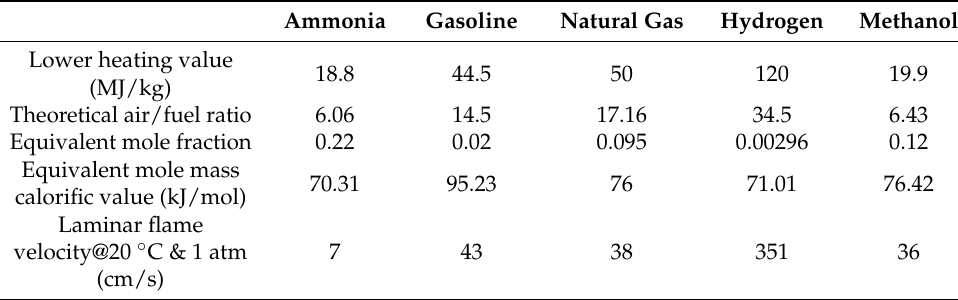
Table 2. Physicochemical characteristics of fuel-air